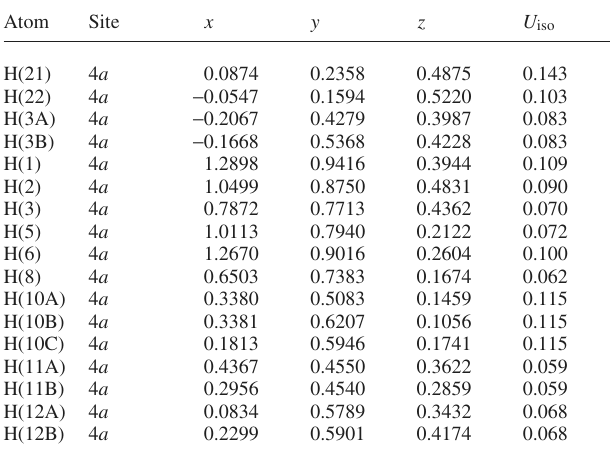
Table 2. Atomic coordinates and displacement parameters (in Å 2 ) .